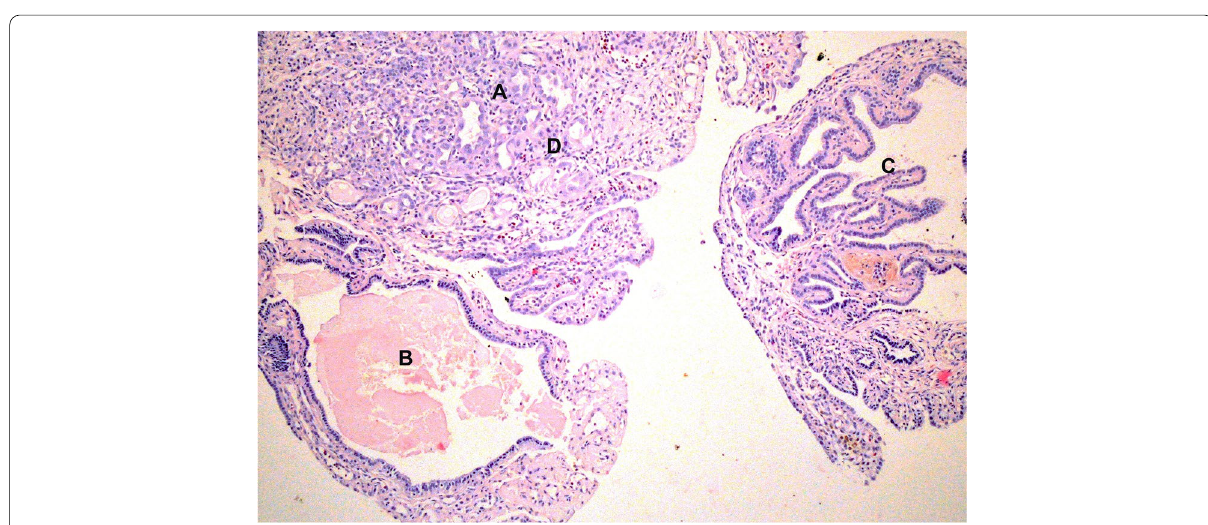
Fig. 2 Bladder nephrogenic adenoma displays structures that look like glands ( A ), cysts ( B ), and papillae ( C ) covered with cubic epithelium; lymphocyte, macrophage, plasma cell, and neutrophilic leukocyte infiltration weakly expressed in the stroma ( D ) (H&E staining,